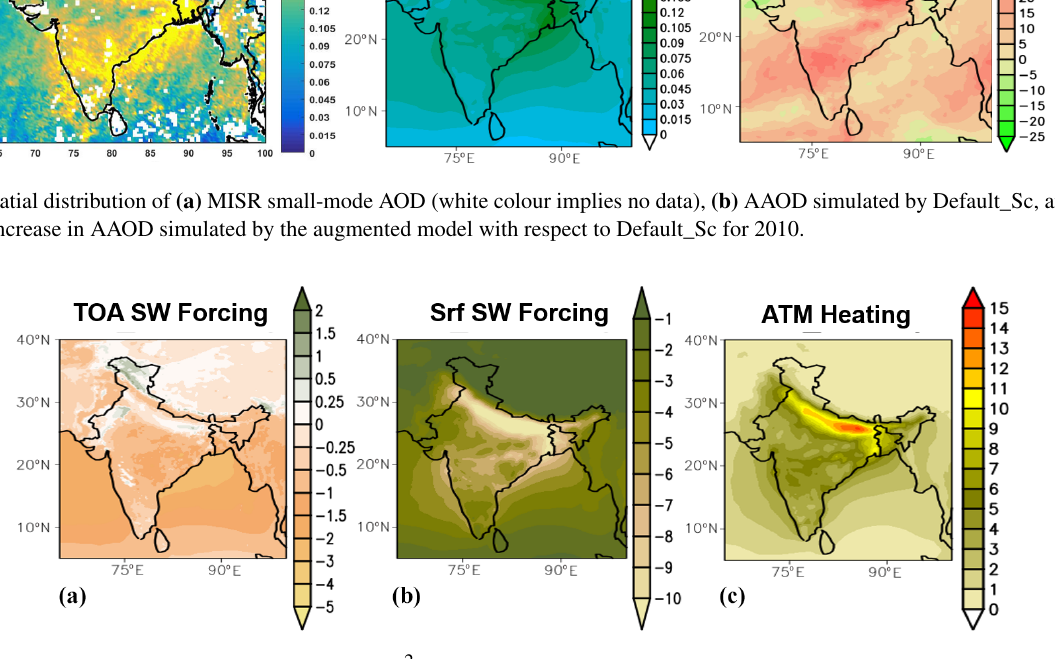
Figure 8. Annual variation in SW radiative forcing (Wm − 2 ) at TOA (a) , at the surface (b) , and the resultant atmospheric heating (Wm − 2 ) (c) for the customized